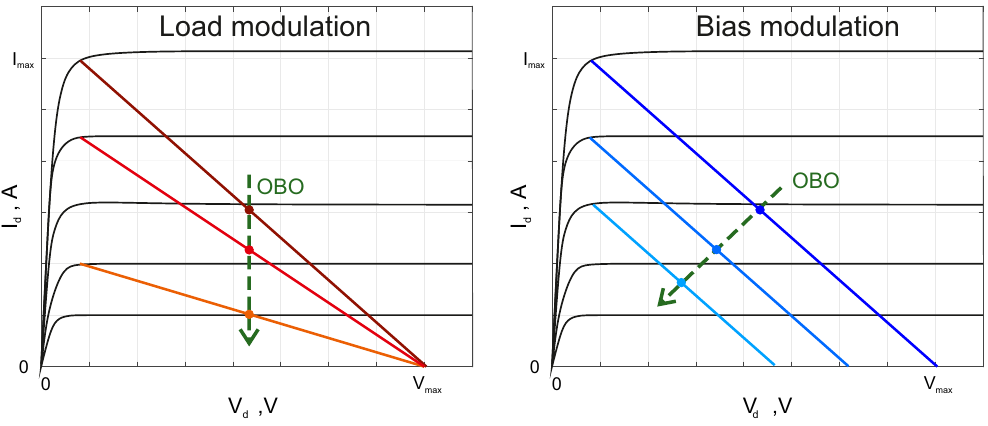
Figure 3. Load modulation and bias modulation principles. OBO: Output power